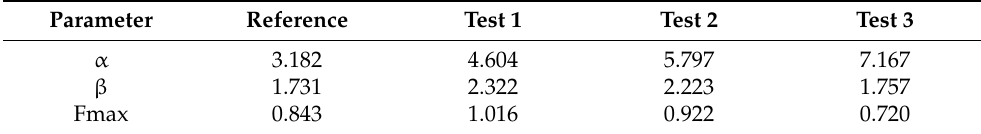
Table 6. Slope (m) and intercept (a) of the linear correlations between the in vivo and in vitro Table 5. Time-scaled Weibull parameters without Test 2 in the Levy plot. Weibull parameters obtained by curve fitting, with the fractions dissolved and fractions absorbed. 4 Products: Reference,